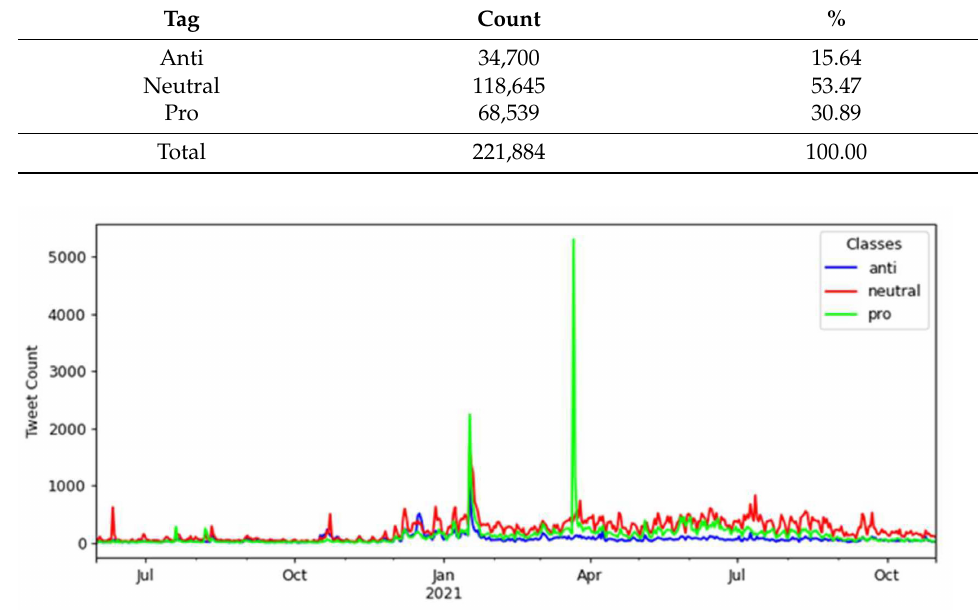
Figure 7. Tweets’ polarity distribution over 17 months about the COVID-19